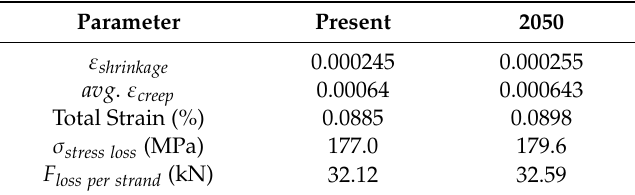
Table 10. Impact of wind load on deflection of prestressed